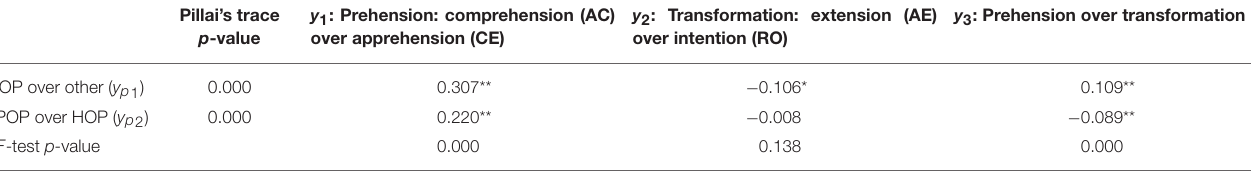
TABLE 2 | Effects from philosophical orientation log ratios on learning style log ratios and joint tests’ p -values. Pillai’s trace p -value